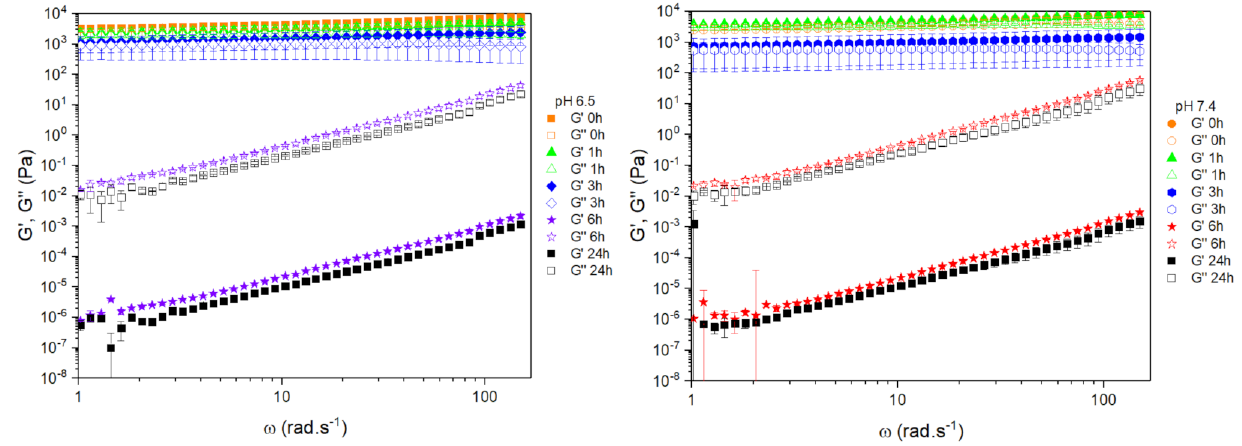
Figure 7. Frequency sweeps of Pluronic 17:3 ratio hydrogel submerged for different times in PBS with pH 6.5 ( left ) and 7.4 ( right ) at 37 ◦